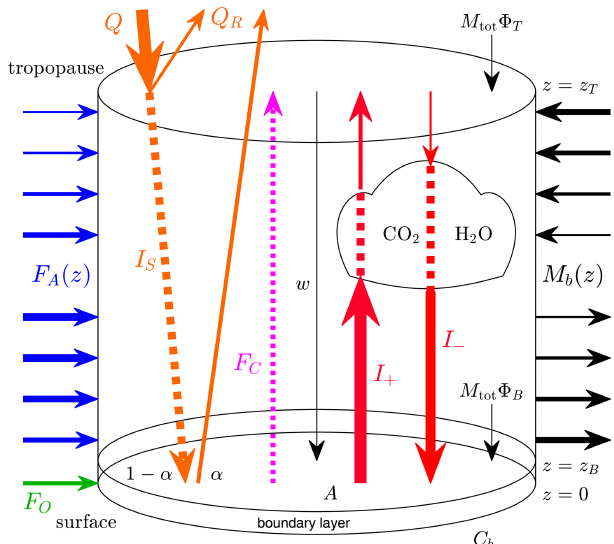
Figure 2. Schematic illustration of the model. Symbols as described in the